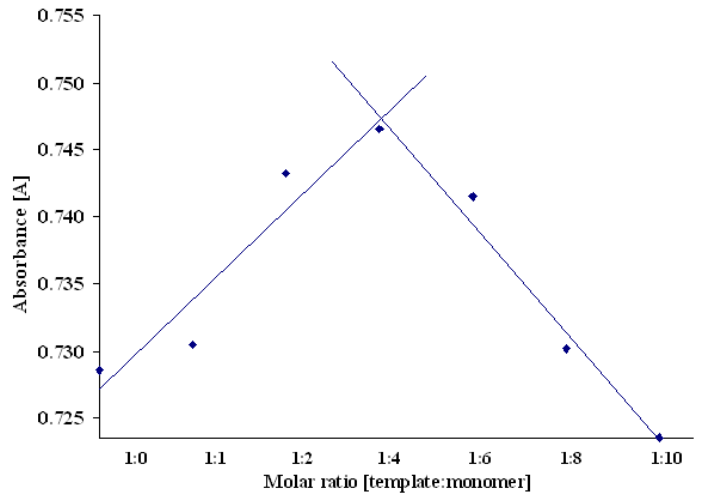
Figure 4 . Job’s plot presenting the relations between absorbance and molar ratio of template to functional